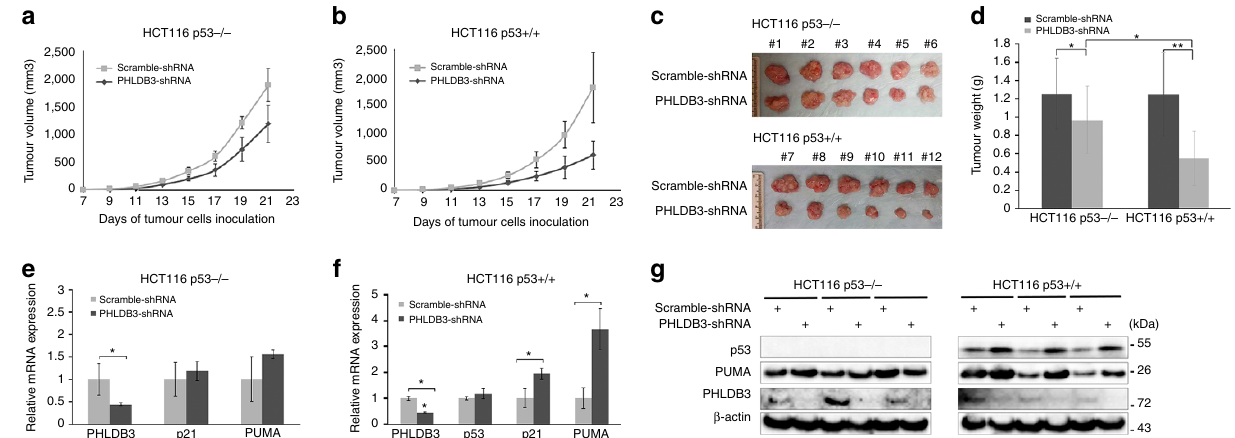
Figure 8 | PHLDB3 knockdown inhibits tumour growth more significantly by inducing p53. ( a , b ) Growth curves of xenograft tumours derived from HCT116 p53 þ / þ or HCT116 p53 (cid:2) / (cid:2) cells that stably express PHLDB3 shRNA or scramble shRNA. Data are represented as mean ± s.e.m. of mouse xenograft tumours ( n ¼ 6). ( c ) The images of xenograft tumours collected at the end of the experiment as shown in a . ( d ) Graphs for the average weights (mean ± s.e.m., n ¼ 6) of harvested xenograft tumours from the above experiments in panels ( a – c ). * P o 0.05, ** P o 0.01 by two-tailed t -test. ( e – g ) The mRNA and protein levels of PHLDB3, p53 and p53 targets were assessed in randomly selected three tumour samples by RT-qPCR ( e and f ) or immunoblotting analysis with indicated antibodies ( g ). Data in e and f are represented as mean ± s.e.m. of three randomly selected xenograft tumours; * P o 0.05. Data shown in g are representative of three individual immunoblotting analyses with antibodies as